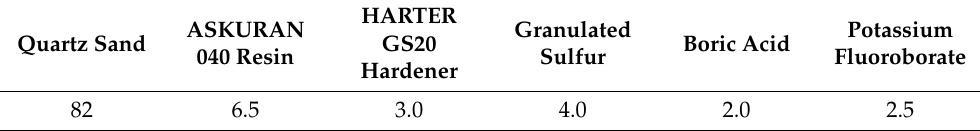
Table 2. Chemical composition of Mrs9 molding sand